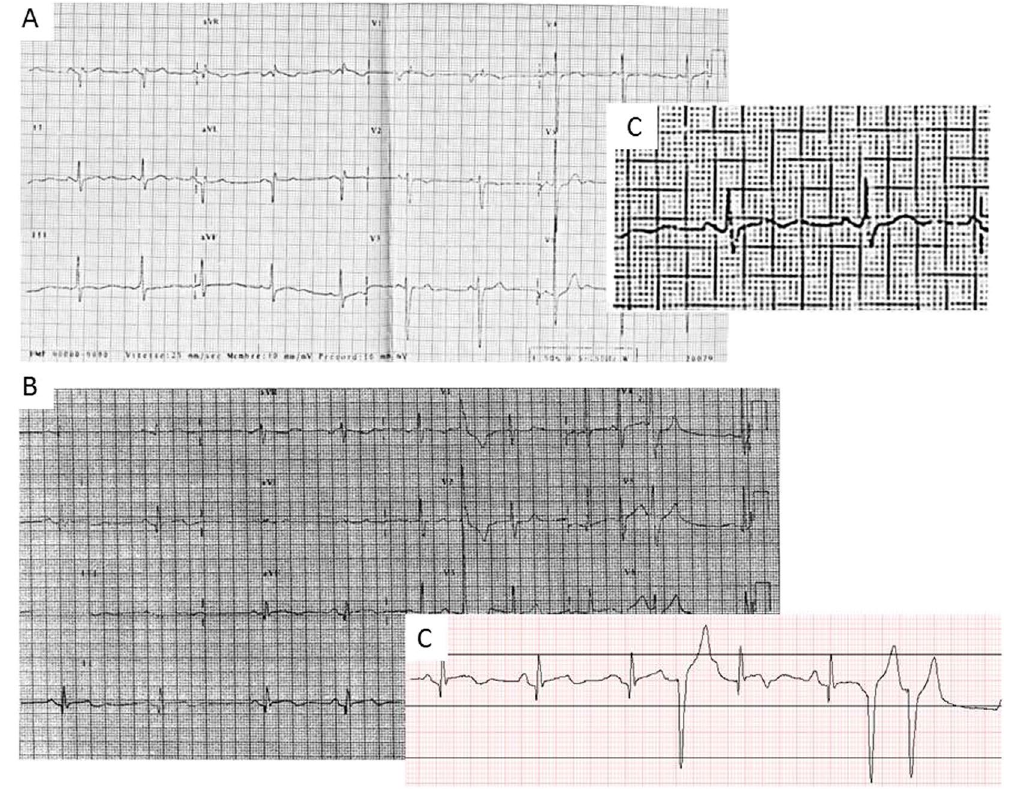
Figure 1. ECG of the 2 TGF β R2 patients who presented sudden cardiac death. ( A ) 17 year-old woman carrying the c.1182 C > G -p.Cys394Trp mutation. Abnormal QRS axis and morphology and significant ventricular repolarization abnormalities with abnormal U waves but normal QTc duration (QTcB = 426